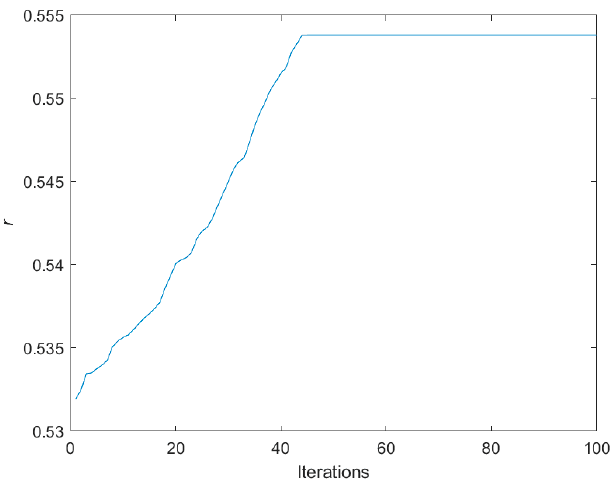
Figure 2. The convergence process of r .